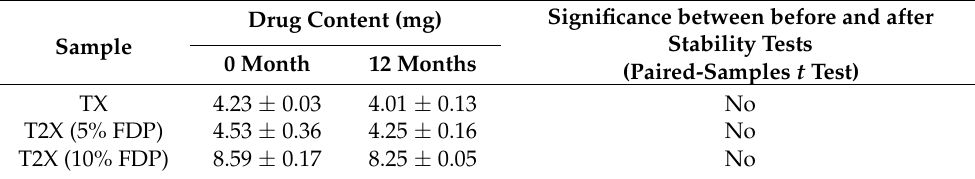
Table 5. Stability studies of 3D-printed tablets with triangle surface geometry.